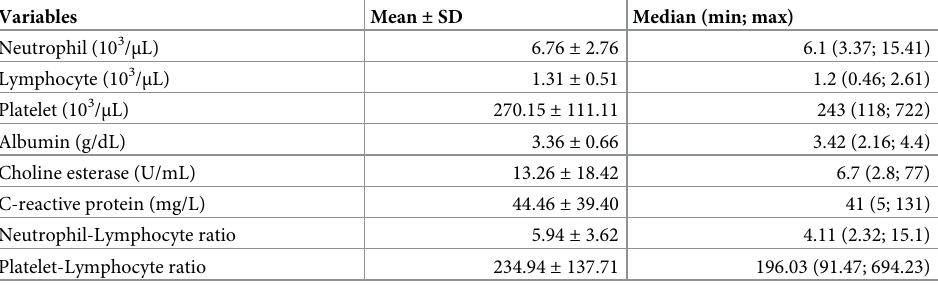
Table 3. The clinical laboratory results (27 HCC